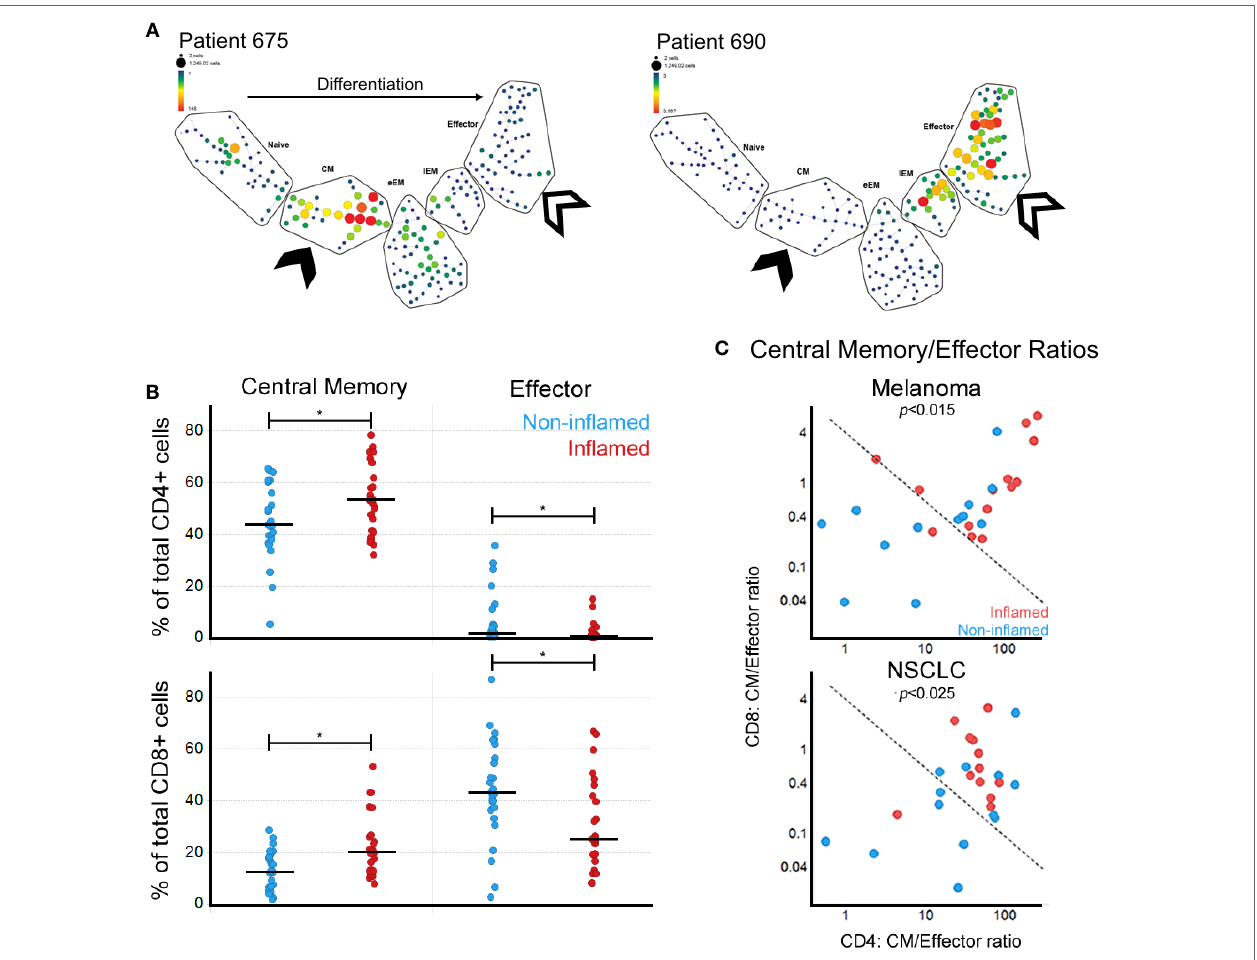
FigUre 2 | Local immune responses in melanoma and NSCLC correlate with circulating central memory (CM)/effector (Eff) T cell ratios. (a) SPADE-generated maturation profiles of CD8 + T cells for two melanoma samples showing the divergent patterns of T cell subpopulations. Both have a reduction in naïve CD8 + T cells but show an expansion in either CM (solid arrow) or the Eff (open arrow) compartments. eEM, early Effector Memory; EM, Effector Memory. (b) Correlation between circulating CM and Eff CD4 + and CD8 + T cells and tumor inflammation state (* p < 0.05). (c) Correlation between CM/Eff T cell ratios by inflammation state in melanoma and NSCLC. Fisher’s exact test p -value for a 0.05 significance level. Dividing line generated based on the 90th percentile of